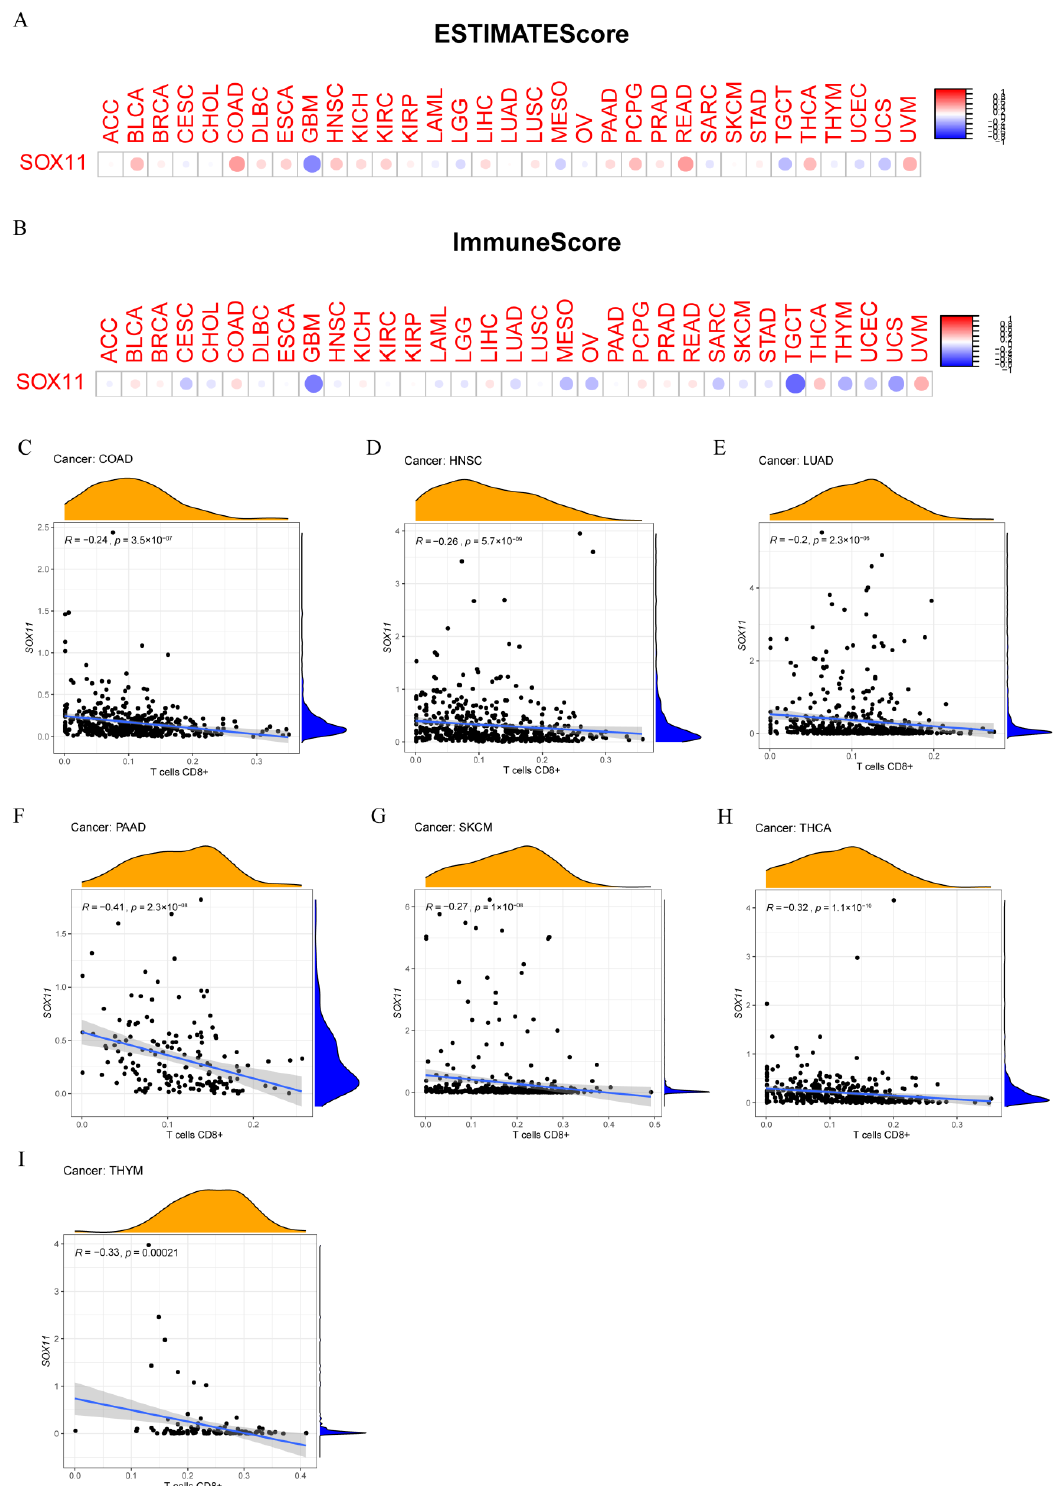
Figure 9. Analysis of the association of SOX11 gene expression with the immune microenvironment. ( A ) An analysis of the relationship between SOX11 expression and ESTIMATEScore in different cancers. The red dots indicate a positive correlation, while the blue dots denote indicate a negative correlation. ( B ) Correlation between the SOX11 expression and ImmuneScore in different cancers. ( C – I ) Correlation between CD8+ T cell infiltration and SOX11 expression in COAD, HNSC, LUAD, PAAD, SKCM, THCA and